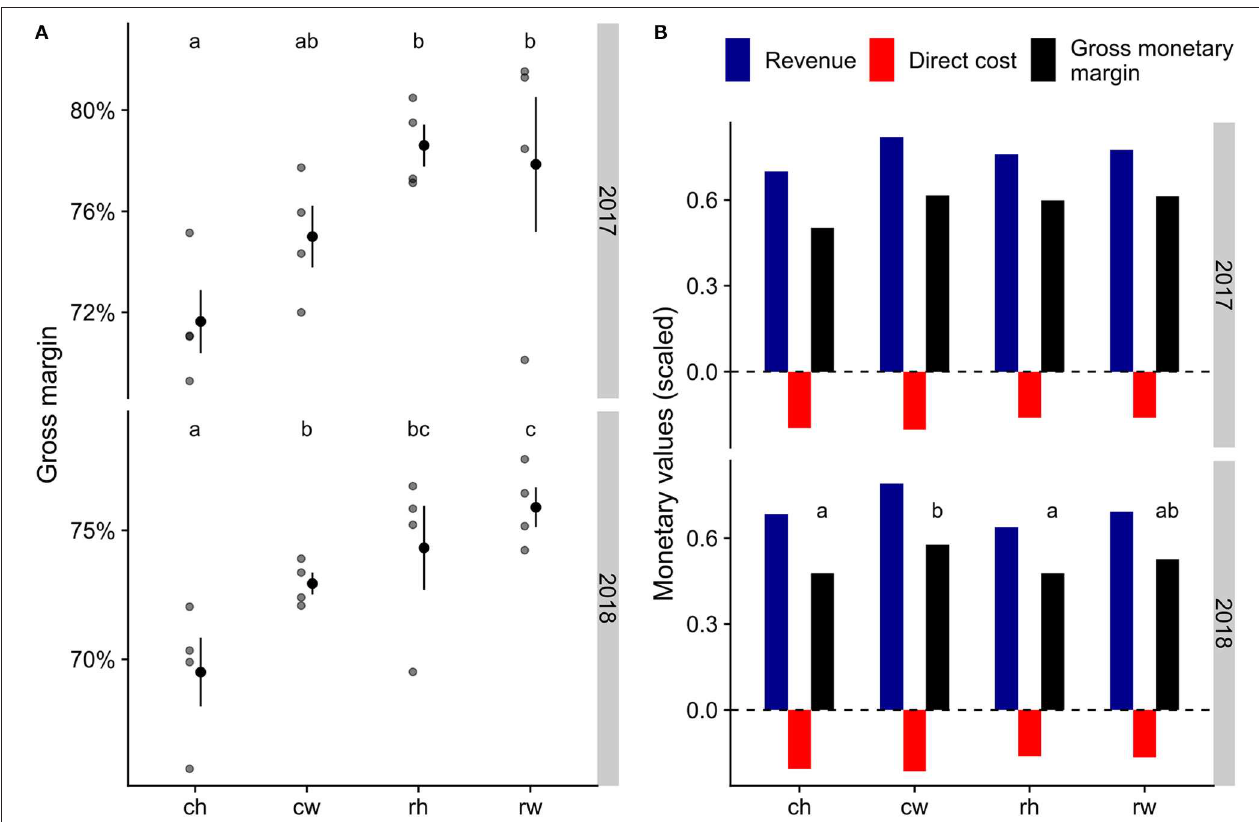
FIGURE 3 | Mean gross margins in percentages (A) and money values (B) are portrayed with the associated cost of inputs and value of outputs for each experimental treatment. Data points are indicated with semi-transparent dots. Mean values are indicated with bigger, opaque dots. Error bars show standard errors of the mean. Revenue and direct costs are shown scaled to the maximum of their values; the difference between these two is the scaled gross margin in money values. Statistically significant differences between means are shown with distinct letters. ch, conventional fertilization, herbicide spraying; cw, conventional fertilization, mechanical weeding; rh, reduced fertilization, herbicide spraying; rw, reduced fertilization, mechanical